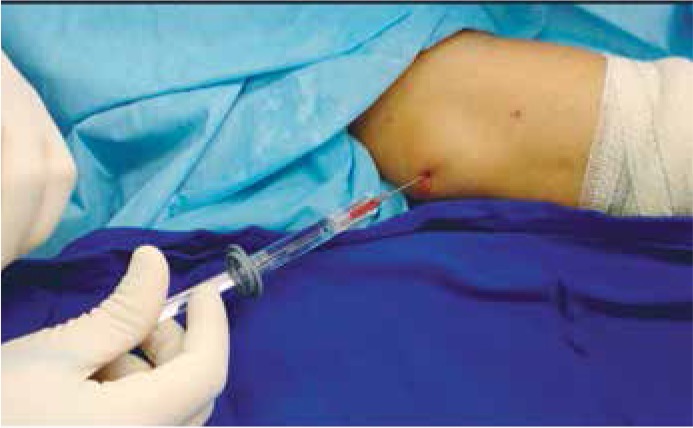
Infiltration with Hylan G-F20 (2 mL) after elbow lavage.